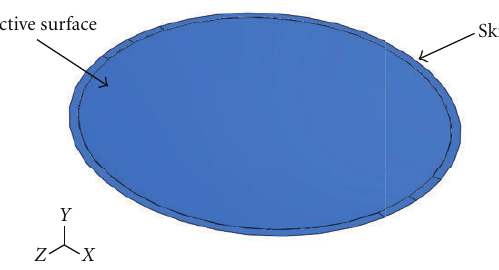
Figure 2: Reflective surface with flat skirt, case